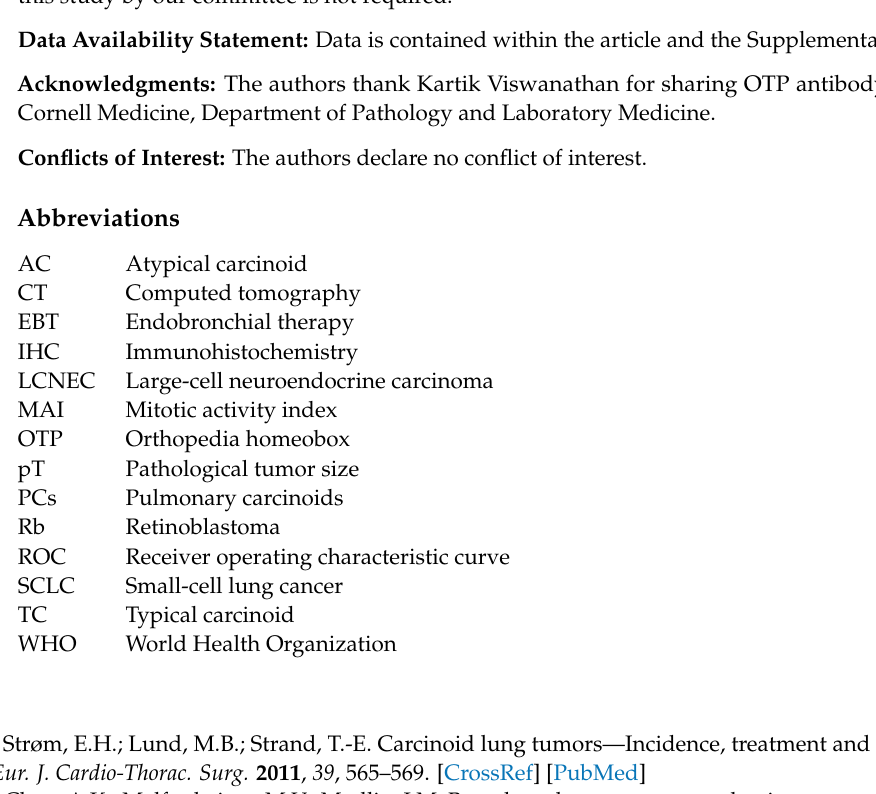
Table S3. Characteristics of patients with neutral biomarker profile ( n =